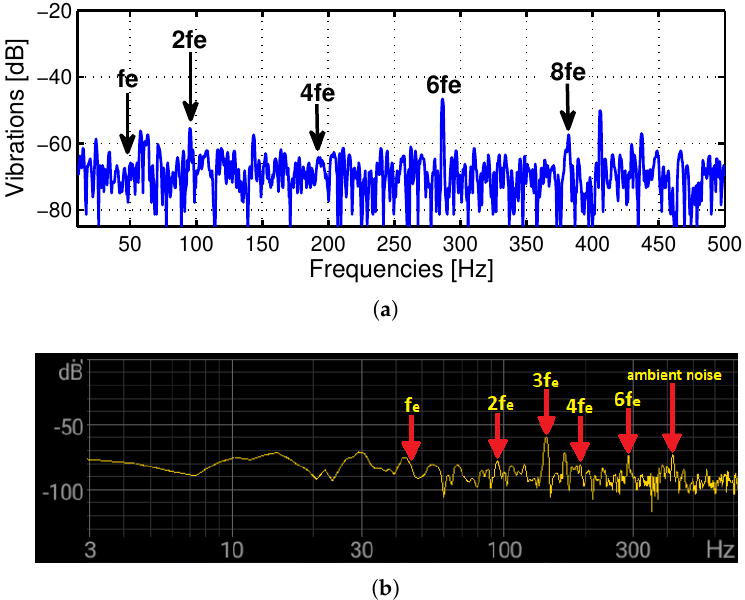
: ( a ) vibrations FFT; ( b ) acoustic noise FFT. s